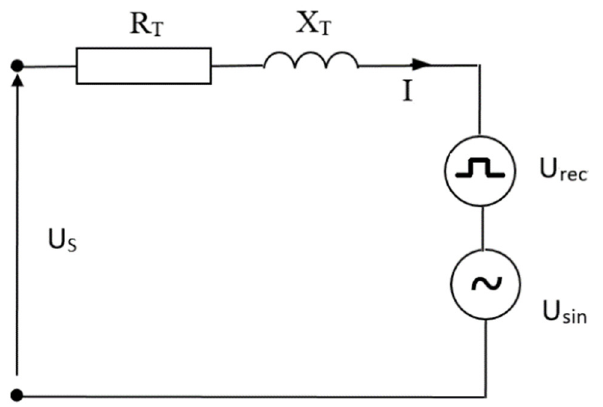
Figure 27. Single-phase equivalent power supply diagram of the arc device.